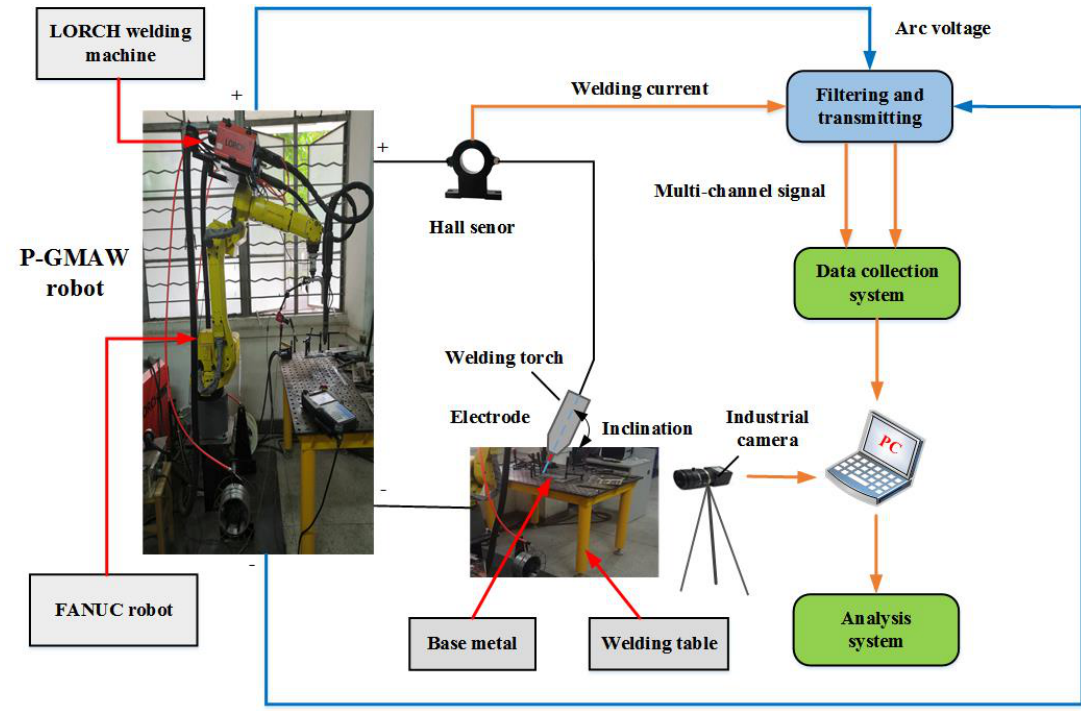
Figure 1. Structure and platform of the experiment.